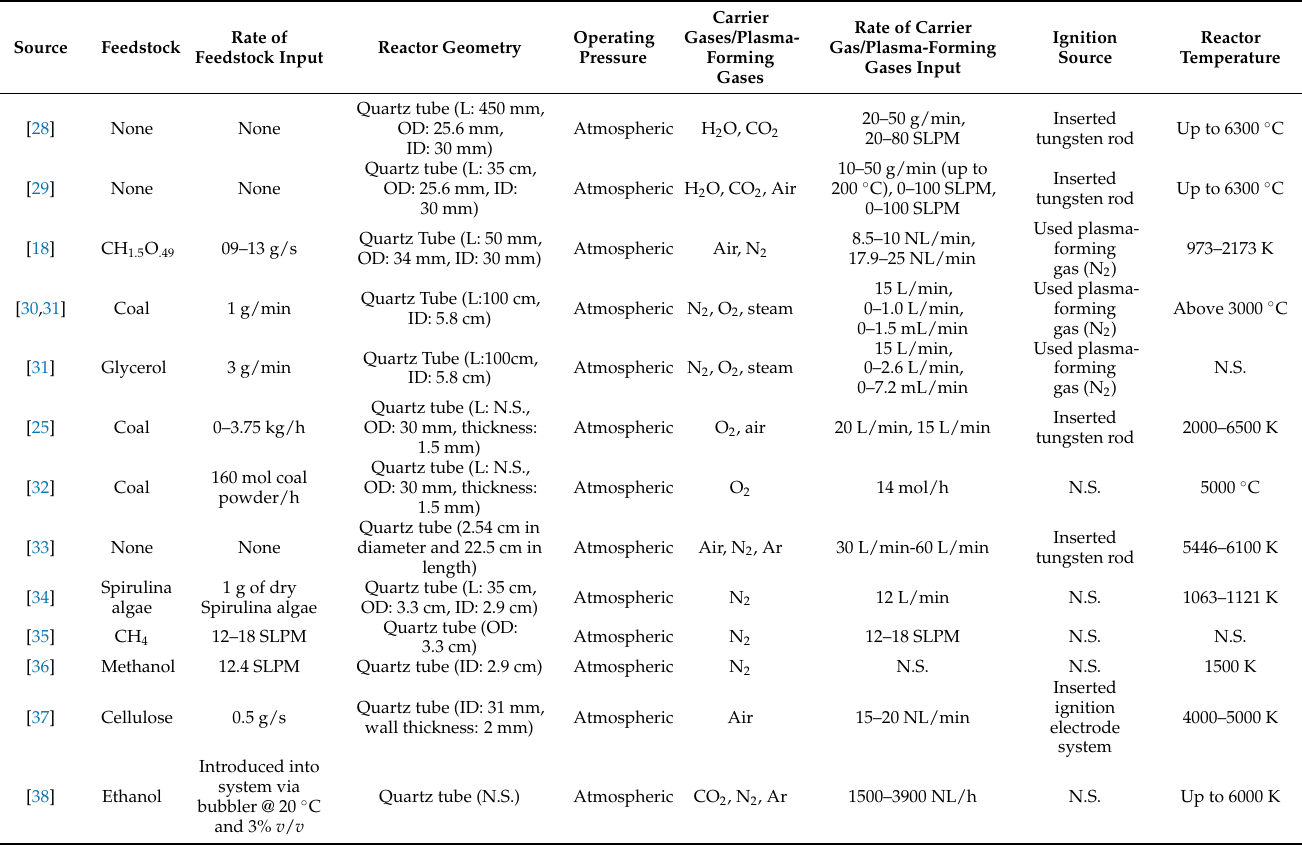
Table 3. Reactor description within EMIPG